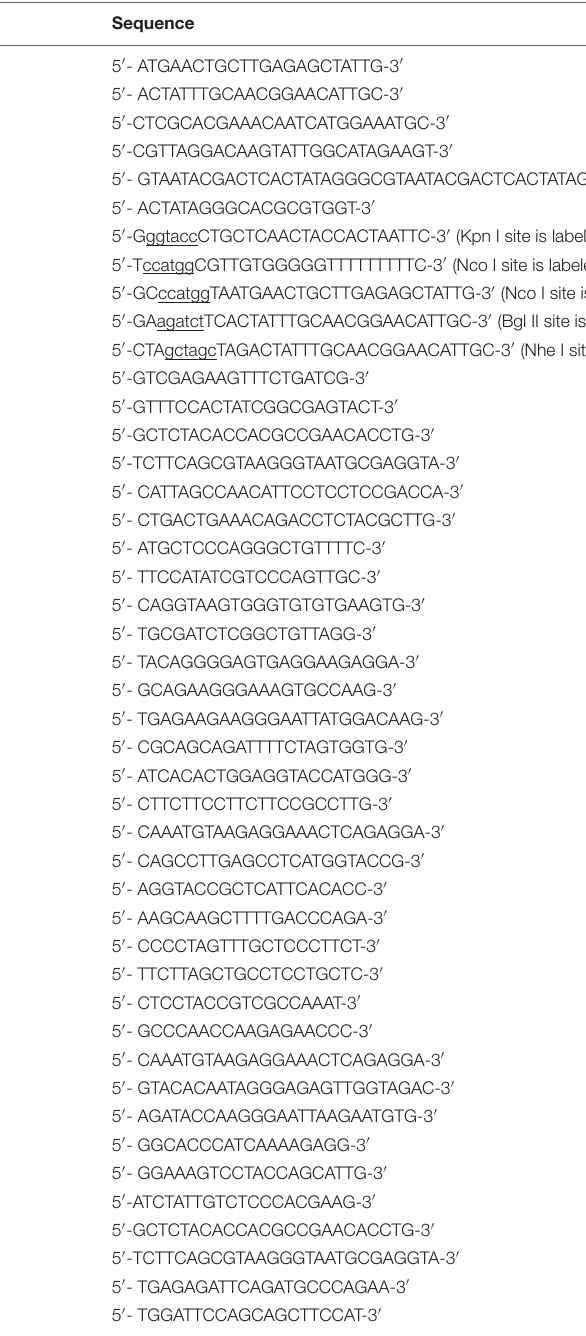
TABLE 1 | Primers used in this